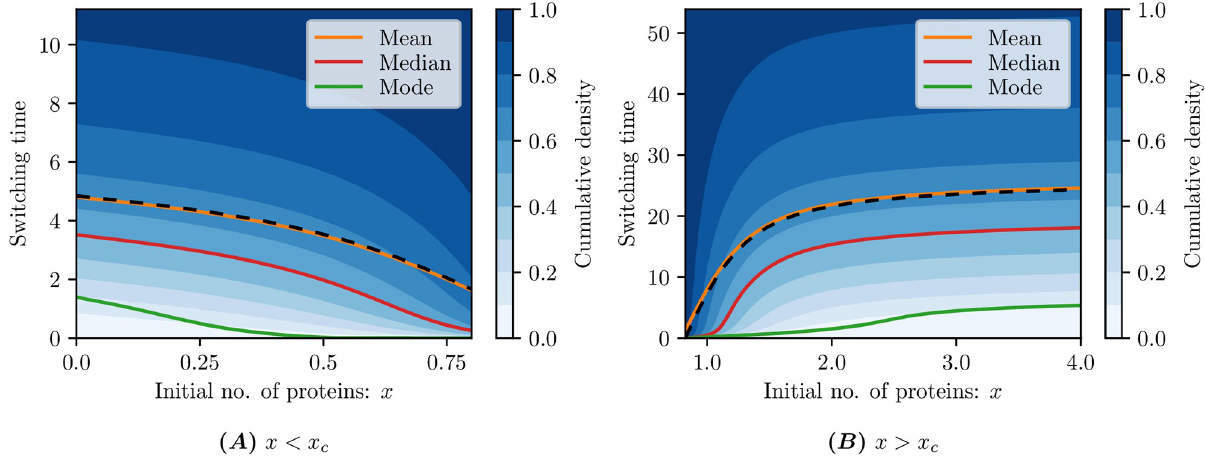
Fig 4. Switching time distributions. For different initial conditions x on either side of the critical x c = 0.825 with an absorption rate α = 1000 and spatial discretisation of Δ x = 0.025 (i.e. lumping 5 states together) up to time t = 150. The exact mean switching time (13), is plotted as a black dashed curve.